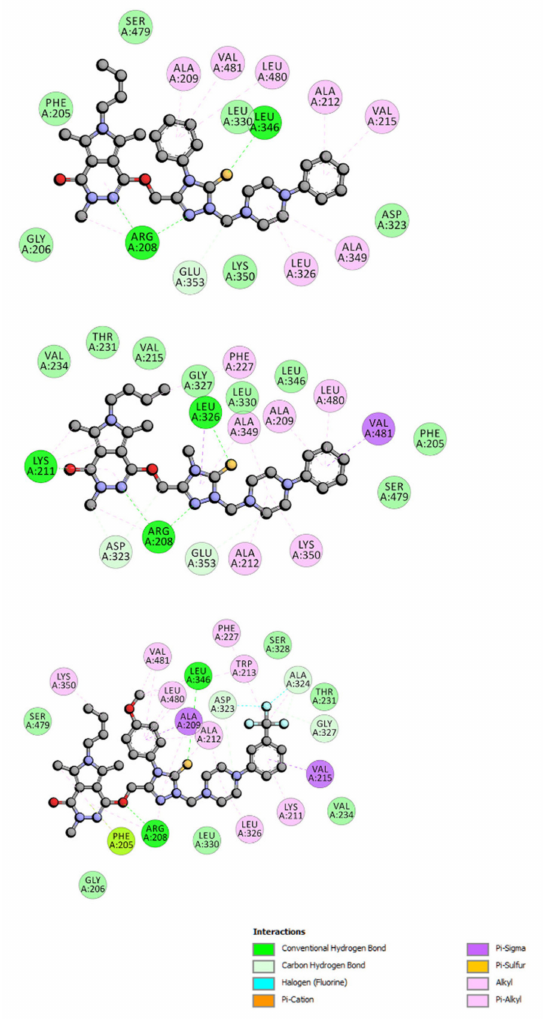
Figure 13. Two-dimensional interaction plot of 4b , 4a , and 5c with BSA in site 2